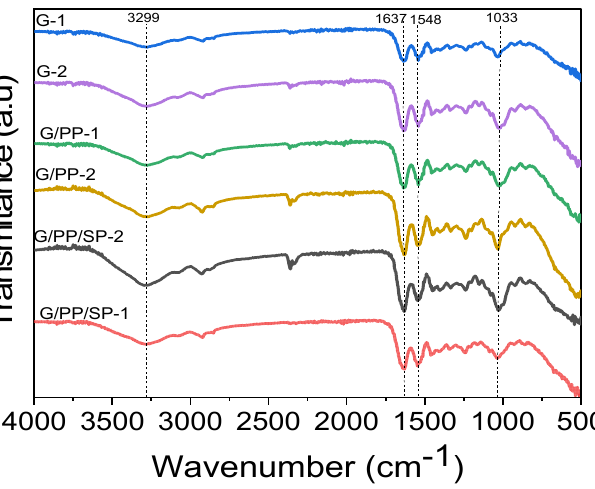
Figure 2. FT-IR transmission spectra of edible films and their composites with gelatin concentration of 6:9 w / w (indicated by blue and violet colors), papaya concentration of 8:10 w / w (indicated by green and brownish-yellow colors), and soy protein concentration 2:4 w / w (indicated by black and red colors) in the range of 4000–500 cm − 1 .